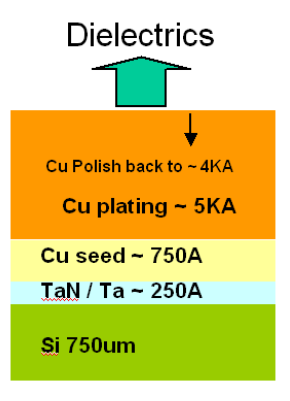
Figure 1. Sample prepared film